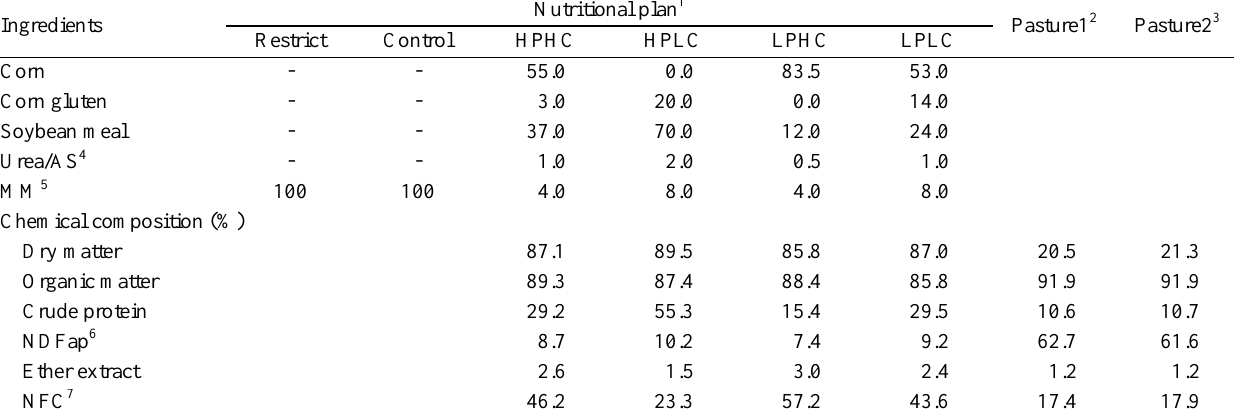
Table 1. Ingredient (as-fed basis) and chemical composition (% DM basis) of supplements and pastures